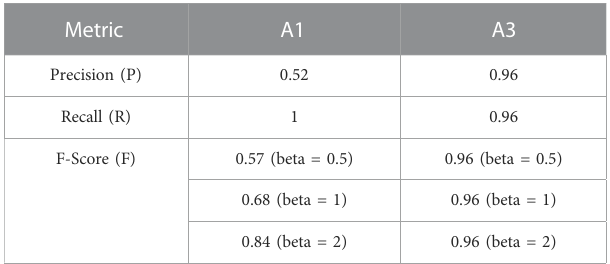
Frontiers in Remote